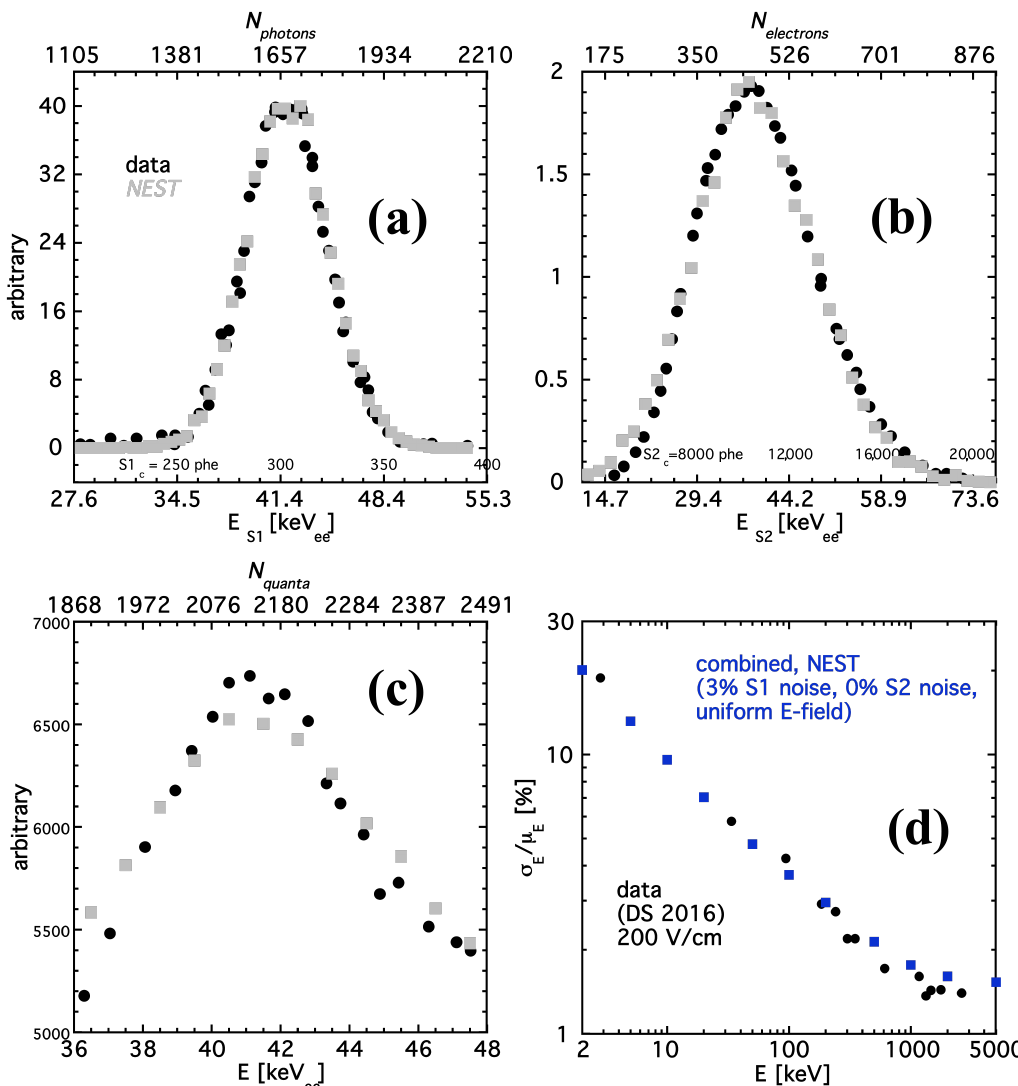
Figure 7. Reconstruction of the 41.5 keV 83 m Kr peak in DarkSide (DS) [23] compared to NEST, with data as black dots, NEST gray squares. For clarity, no fits overlaid, although most data are ∼ Gaussian. ( a ) S1-only E scale most common for LAr-based DM detectors [22]. Our work/conclusions for such a scale should apply not only to time projection chambers (TPCs) where ionization e − s are drifted but also to 0 V/cm 1-phase detectors, where these electrons fail to recombine to add to the S1 in LAr for both ER and NR [158,166,167] just as in LXe [32], with the L y having the same shape vs. E as for non-zero fields as field goes to 0 in TPCs (see Doke et al. as well as Wang and Mei for possible reasons [78,141,168,169]). ( b ) S2-only, with the slight right-hand asymmetry nearly reproduced by NEST [21]. ( c ) Combined- E scale, now standard at least in DS. Optimization as done in LXe could be possible, but not shown. Resolution is poorer than in ( a ) instead of better due to poor S2 resolution in ( b ) and that S2 is being combined with S1, on top of 39 Ar. This is explained in the text, as likely due to lack of XY correction creating noise not correlated with S1. For E s below 1 MeV, like here, this is not likely due to delta rays not being simulated by NEST by itself, as no S2 noise (and little in S1) is needed in the next plot ( d ) and S1 is not as wide as S2 in ( a ), while delta rays would affect both. Combined E , canceling them, should still be better in general in Ar as in Xe. ( d ) Resolution vs. E for monoenergetic calibrations/backgrounds studied on DS [23]. Only one set of resolutions covering a broad E range was found (black) to compare to combined E from NEST